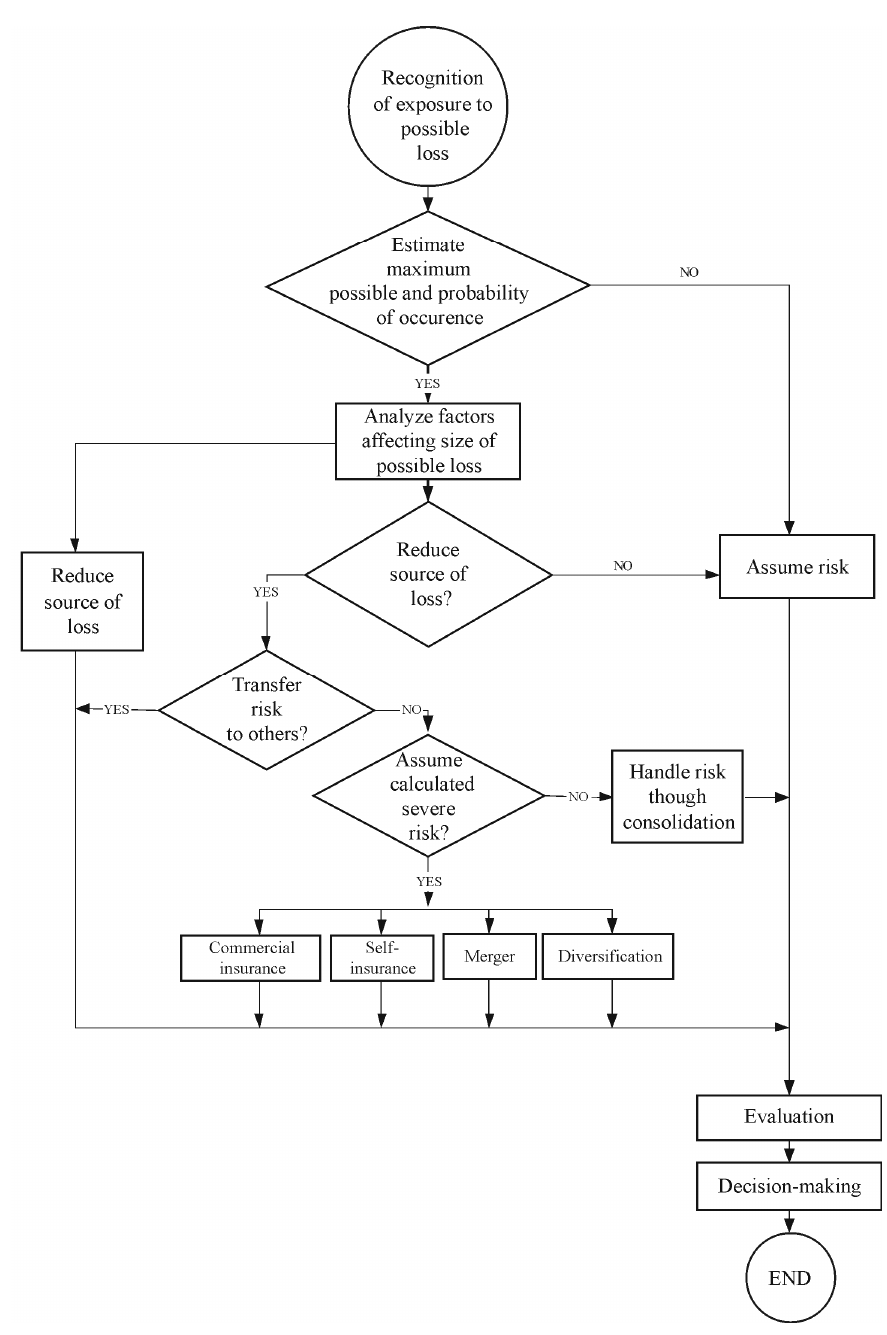
Fig. 3. Decision making model of risk